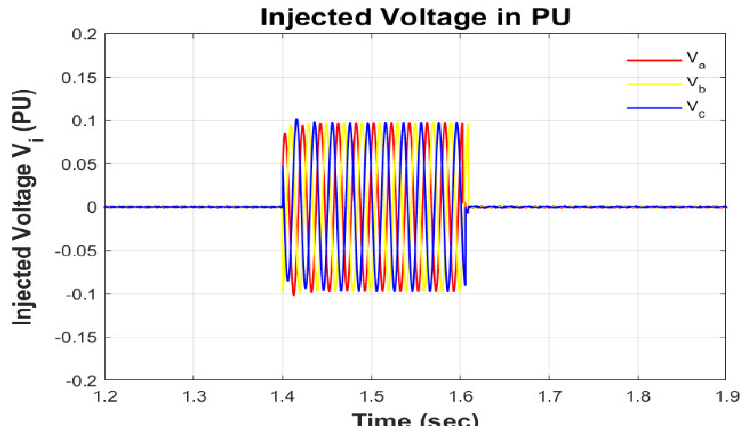
Figure 24. Injected voltage during three − phase fault.